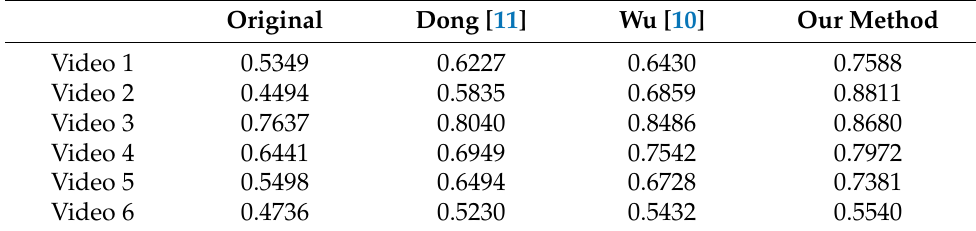
Table 7. SSIM for shaky videos with